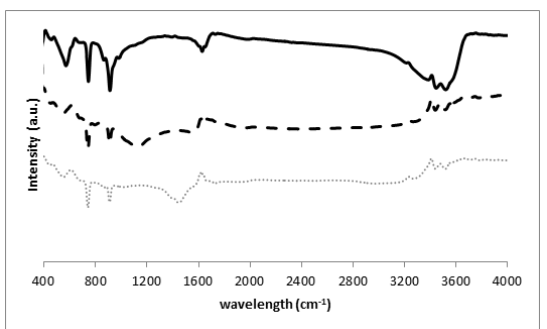
2 ), ()AC(H 2 SO 4 ), ()AC(NaOH)